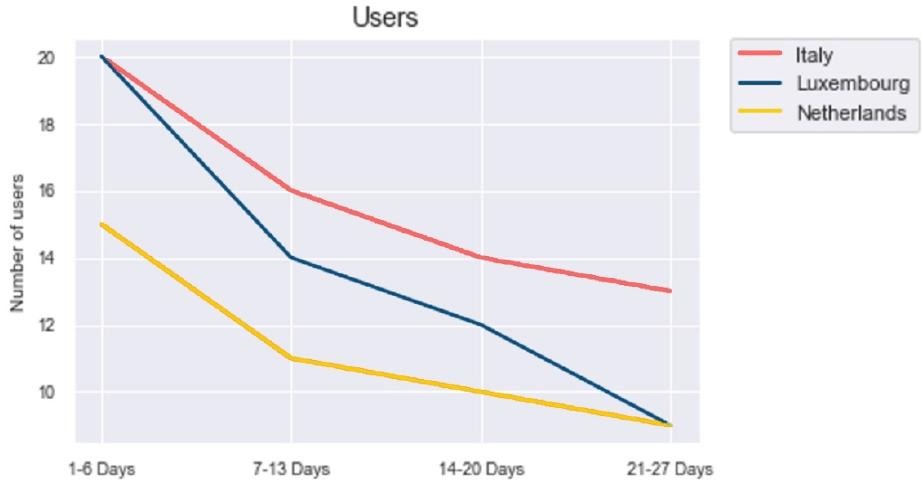
Figure 3. Number of users over time.